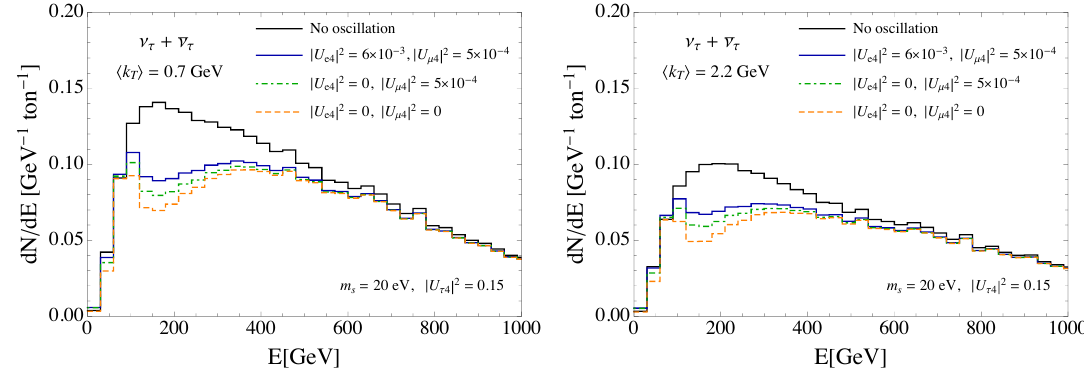
Figure 13 . Predictions of the number of (cid:23) (cid:28) + (cid:23) (cid:28) charged-current events as a function of neutrino en- ergy in absence of oscillations and in presence of oscillations in a 3+1 mixing framework, for various choices of the oscillation parameters in the same experimental setup already used in section 4. Num- bers of events are reported for a ton of lead detector, for h k T i = 0.7 GeV (left) and 2.2 GeV